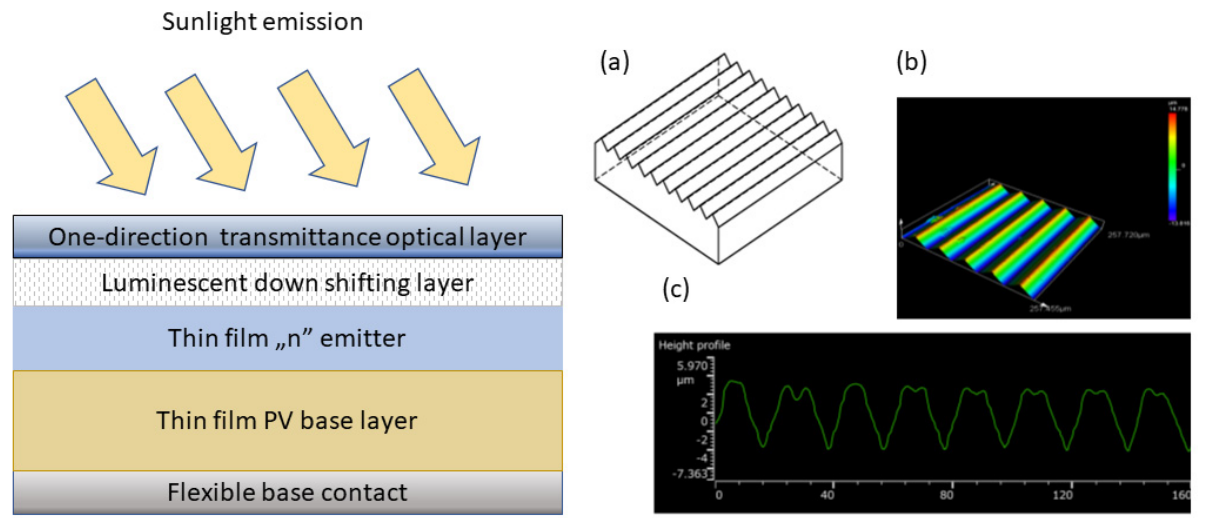
Figure 11. A proposed new structure of a thin film solar cell with a luminescence–based flat optical converter with polymer texturization for antireflective coating; ( a ) polymer foil pattern; ( b ) a photograph of the actual prototype; ( c ) a profile of the foil cross-section with the specific dimensions. Based on [132].